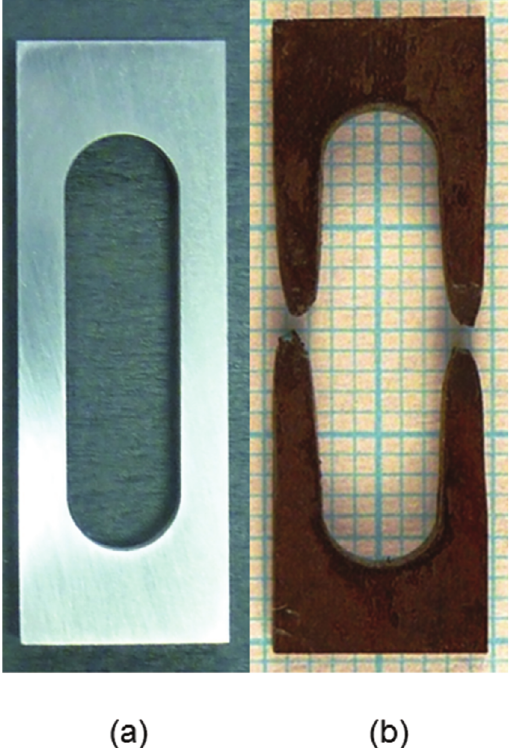
Figure 19: (a) Polished untested specimen; (b) tested specimen.